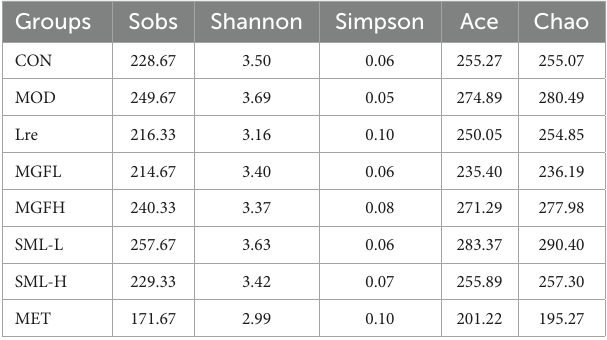
TABLE 2 Abundance and diversity indices of microbial